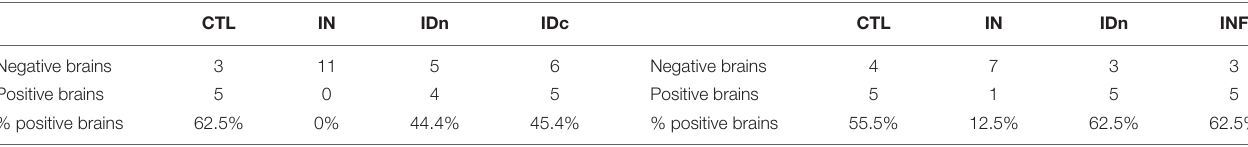
TABLE 1 | Number of cyst-positive brains from latent toxoplasmosis experiment (on the left) and transplacental transmission experiment (on the right). CTL IN IDn IDc CTL IN IDn INF Negative brains Negative brains